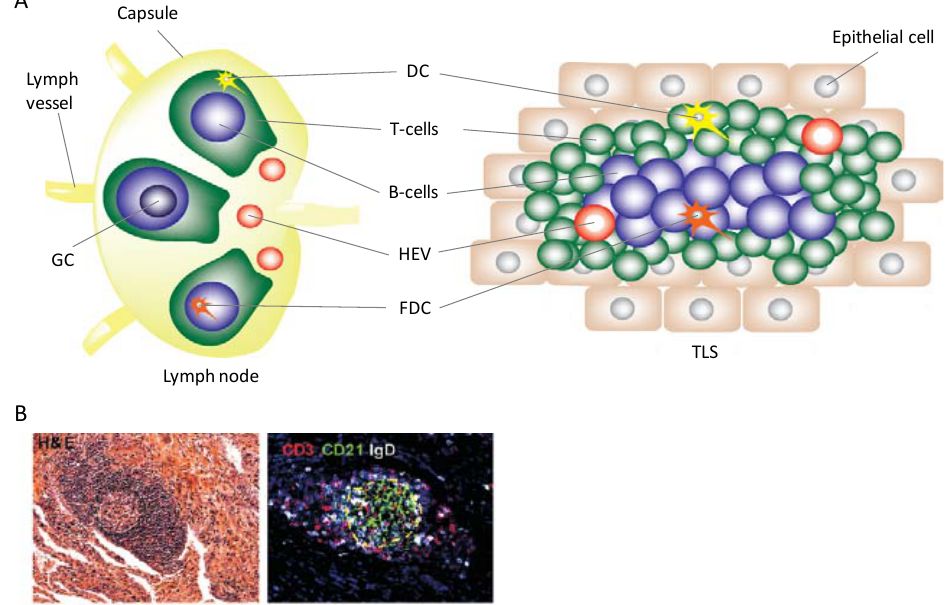
Figure 1. Histological similarities and structural differences between lymph nodes and TLS. ( A ) Both lymph nodes and TLS contain the same cell populations and high endothelial venules (HEV). On the left, a schematic of lymph node structure highlighting B and T cell zones is shown. Each zone contains resident cell populations that upon antigen presentation by follicular dendritic cells (FDC) or DC, and subsequent activation, undergo clonal expansion. Expanded B cell populations form a germinal center (GC). On the right, a TLS schematic showing individual cells aggregating which mimics lymph node histological structure is shown. B cells in this case will also clonally expand and form germinal centers after antigenic stimulation. Structural differences are highlighted; lymph nodes are encapsulated and connected to the lymphatic system via afferent and efferent lymph vessels while a TLS forms within a chronically-inflamed tissue and lymph vessel formation may eventually occur [6]; ( B ) Tissue specimen of TLS structures seen in tuberculosis infection. The left is an H&E stain; the right is an immunoflourescence image staining for CD3 + T cells and CD21 + IgD + B cells